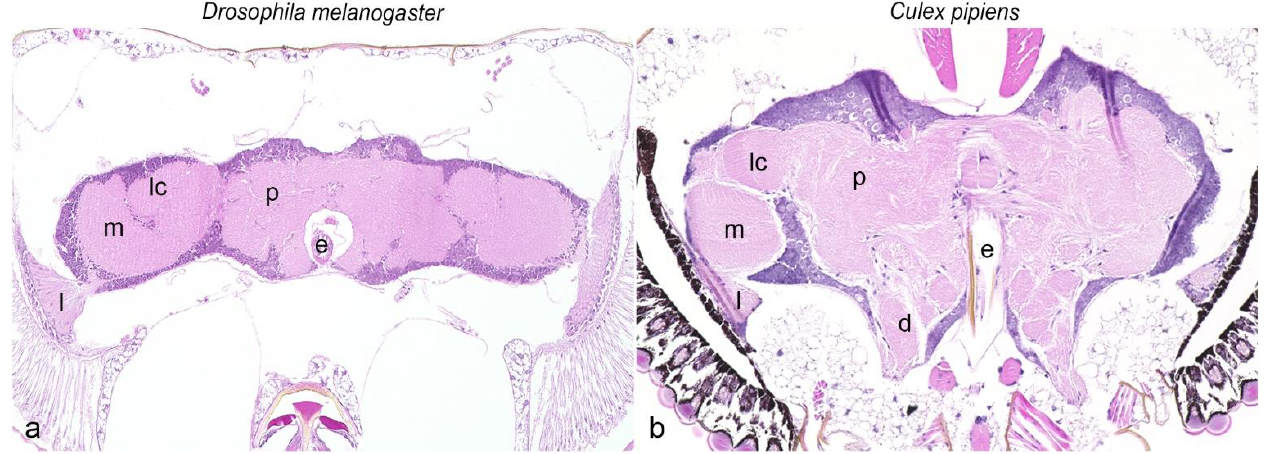
Figure 1. Comparative illustration of head ganglia from Drosophila melanogaster ( a ) and Culex pipiens ( b ), hematoxylin and eosin. Magnification ×20. e: esophagus; d: deutocerebrum; l: lamina; lc: lobula complex; m: medulla; p: protocerebrum. Table 2. Immunoreactivity of tested antibodies in Culex pipiens biotype molestus compared to Drosophila melanogaster .